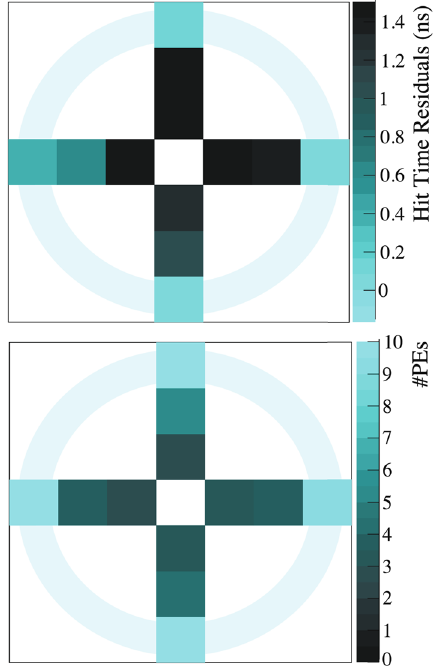
Fig. 6 (Top) Average hit-time residuals and (Bottom) average number of PE versus PMT position for ring candidate events in LAB. No hit selection is applied here, i.e. this is prior to application of the t c timing cut